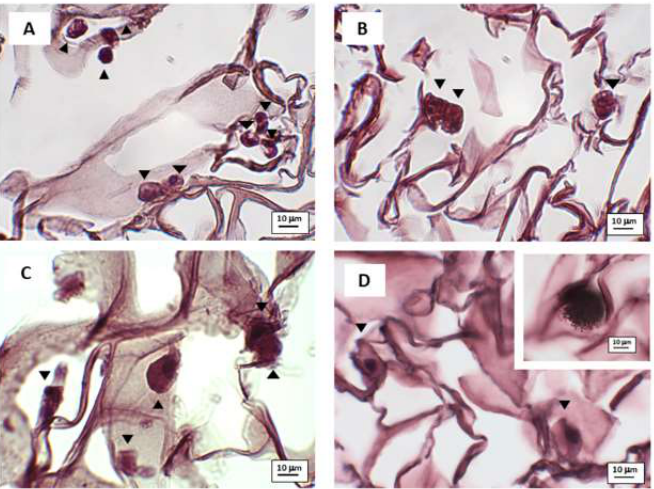
Figure 3. Photomicrographs of optical microscopy observation. hASCs were grown in FWM for 24 ( panel A ), 48 ( panel B ), 72 ( panel C ) and 96 h ( panel D ). The cells were stained with haematoxylin–eosin. The inset shows an apoptotic cell. Arrowhead indicates the cells.